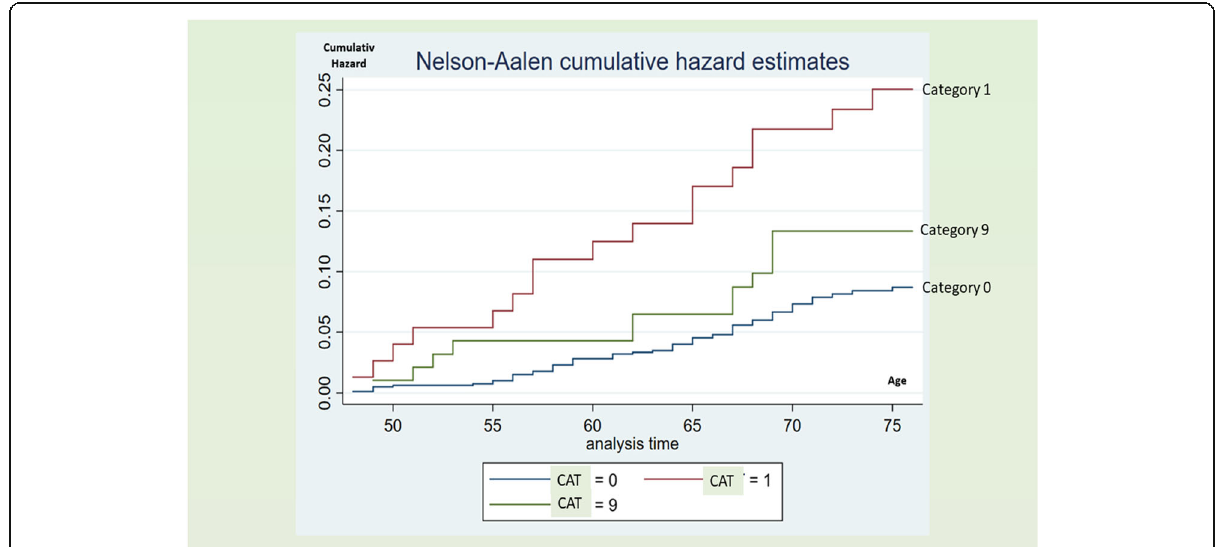
Fig. 2 Nelson-Aalen Cumulative Risk Estimates for Myocardial Infarction by category in 977 men. Note: ECG category 0, ECG performed in 1993 and 1998, no ECGA; ECG category 1, ECG performed in 1993 and/or 1998 with one or more abnormalities; and ECG category 9, ECG performed in 1993 or 1998 without